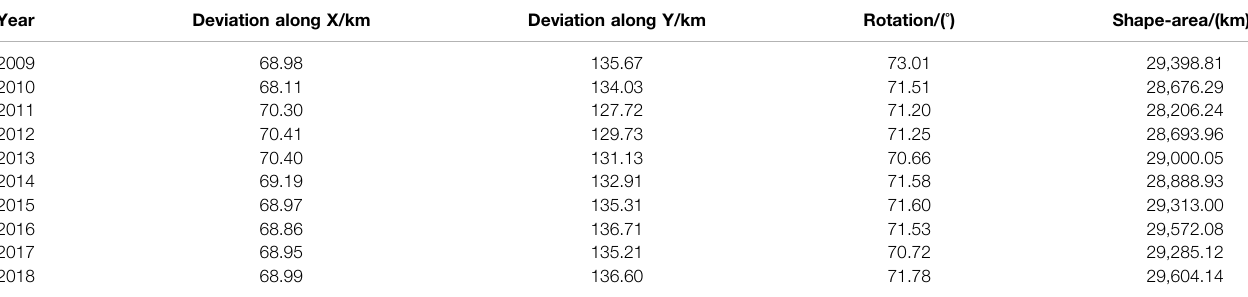
TABLE 3 | The parameters of standard deviational ellipse of the river basin sustainable development. Year Deviation along X/km Deviation along Y/km Rotation/( °